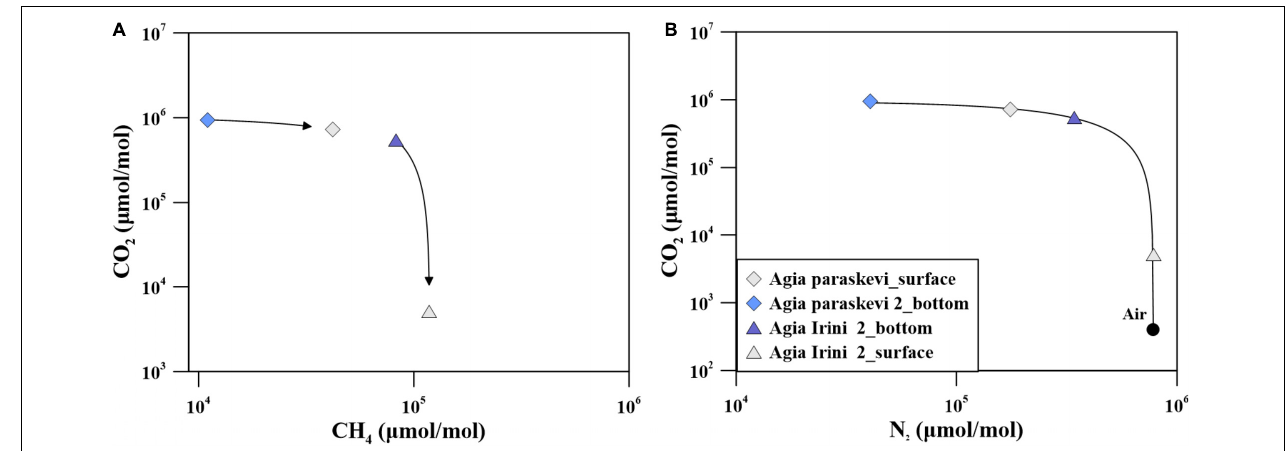
FIGURE 10 | Binary plot of (A) CO 2 -CH 4 and (B) CO 2 − − N 2 . Lines in (A) indicate the course toward less soluble gas species, while the line in (B) indicates mixing from the deeper to the shallower gas sample and then to the atmospheric end member. Values of air after Kipfer et al. (2002).